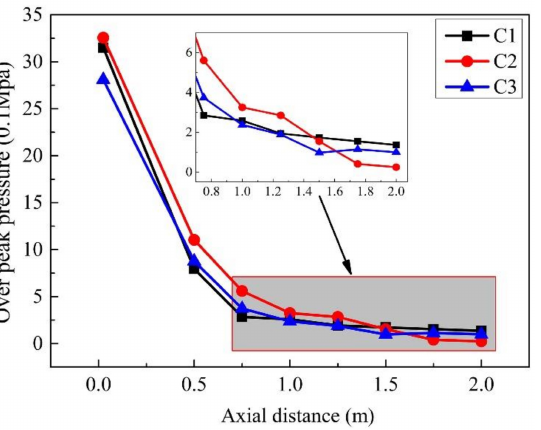
Figure 20. The peak pressure of the gauge points in the case of different explosion heights. The peak pressure of the gauge points in different horizontal positions of explosives are shown in Figure 21. The distance shown in the figure is the distance between the observation point and the position of the C1 explosive. For different explosive horizontal positions, the attenuation trend is the same in all cases: the farther away from the explosive position, the lower the pressure. Compared with other scenarios, placing explosives at the center of the composite steel structure has the best damage effect.